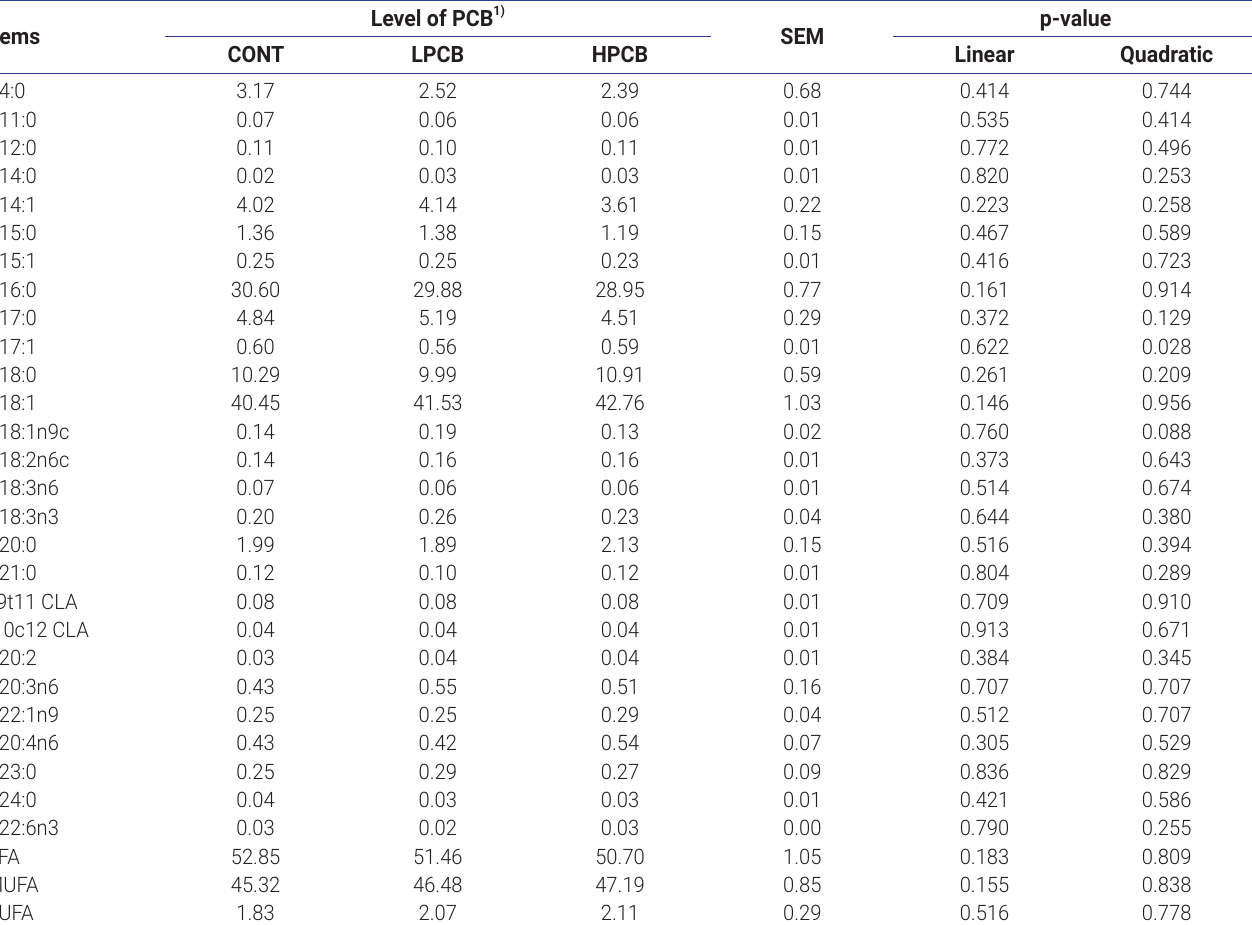
Table 7. Effects of pineapple cannery by-product on longissimus muscle fatty acid profiles (g/100 g) of finishing Hanwoo steers Level of PCB 1) Items